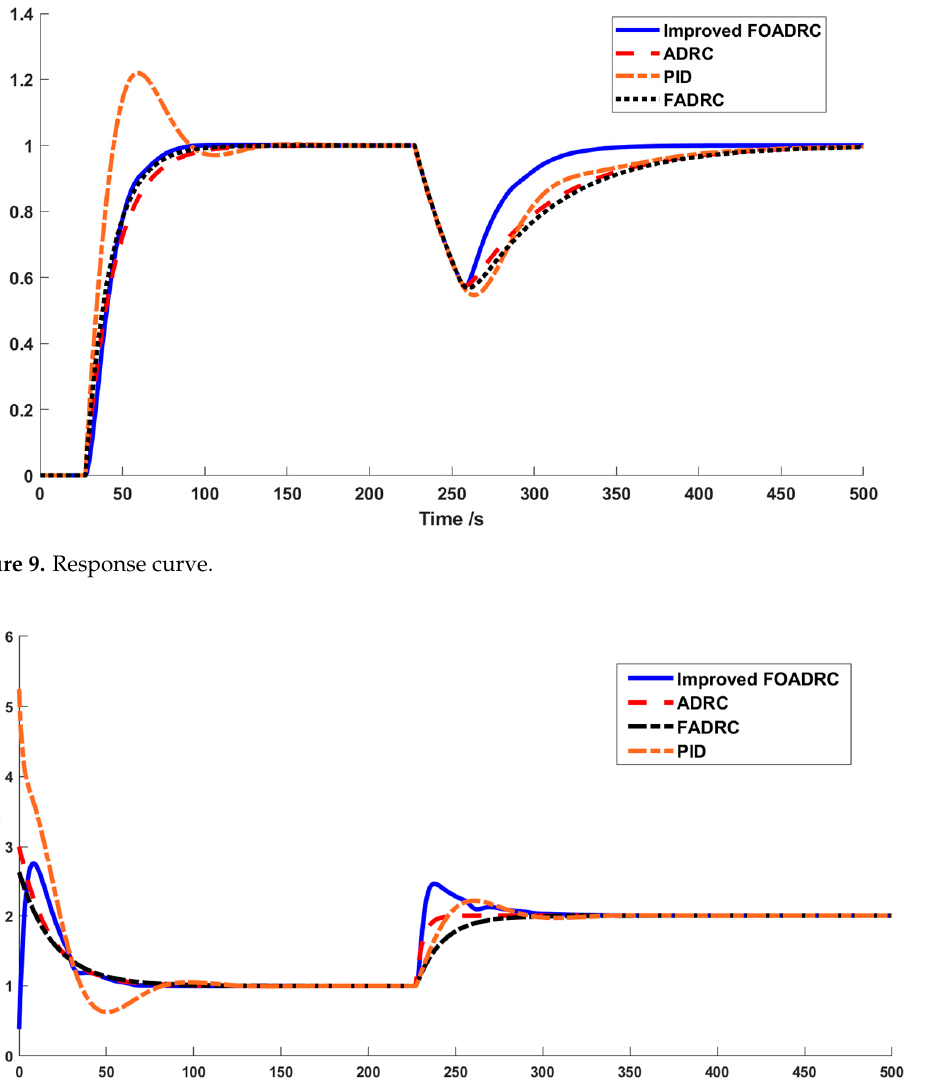
Figure 8. Feedforward control e ff ect.